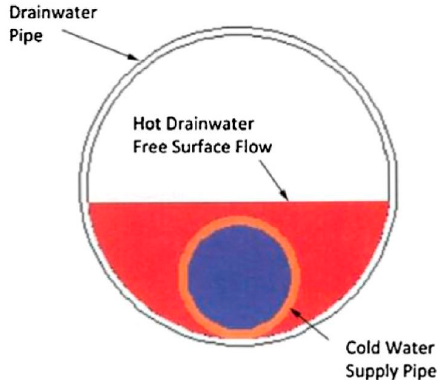
Figure 14. Proposed solution for horizontal HEs [47].